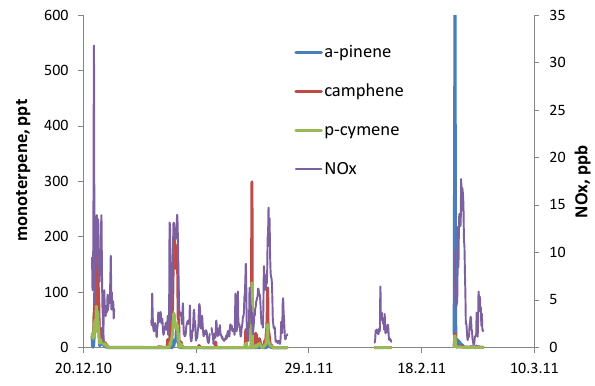
Fig. 4. Monoterpene winter episodes 18 December 2010–28 Febru- ary 2011.